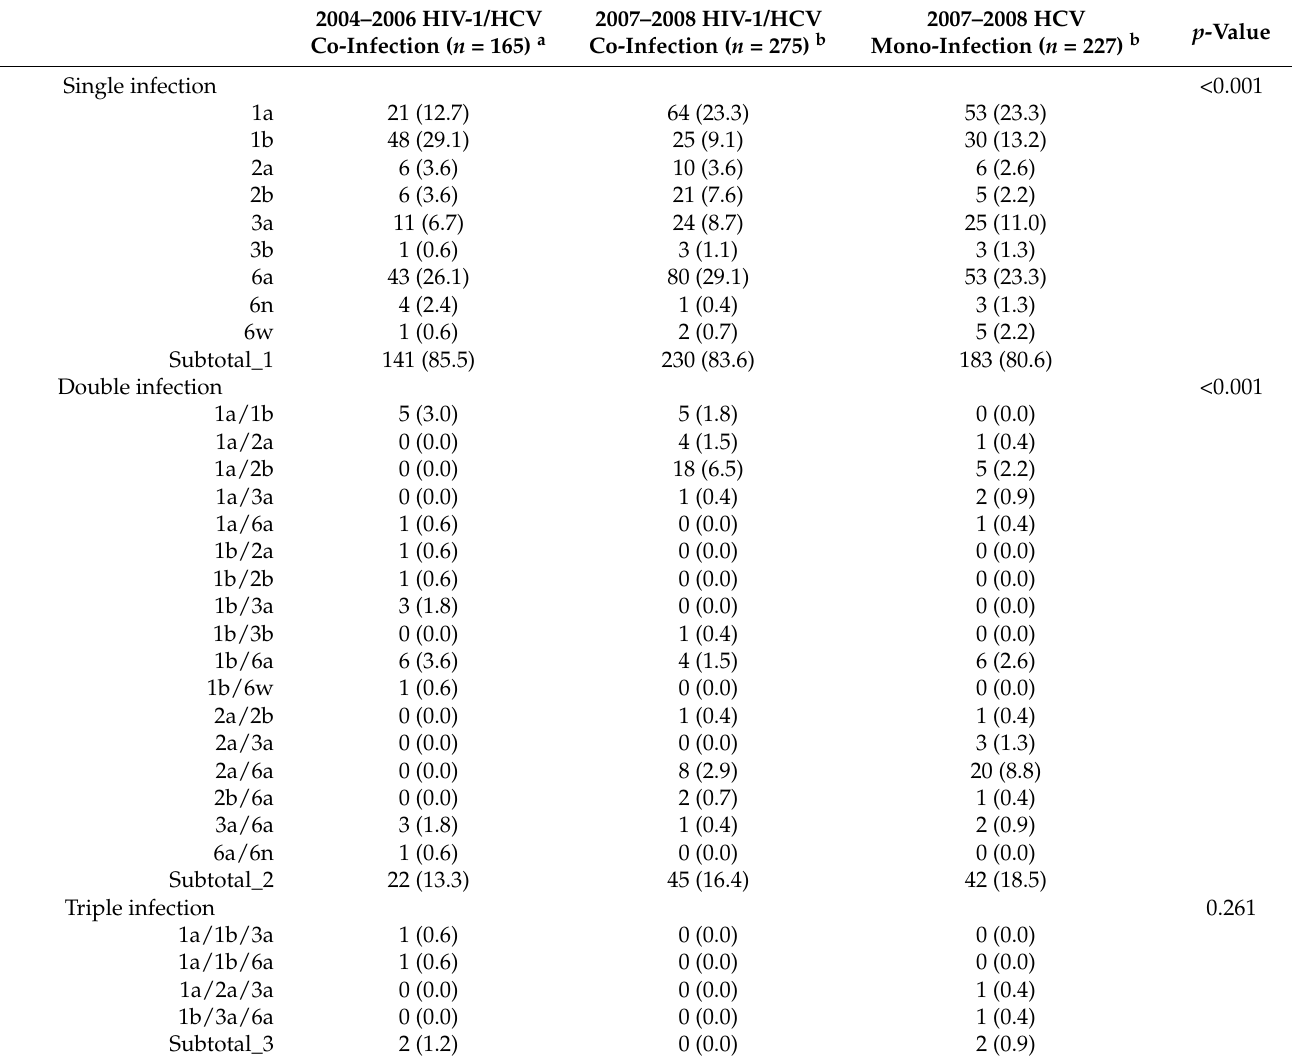
Table A1. Distribution of HCV genotypes/subtypes in the different groups among Taiwanese PWID. 2004–2006 HIV-1/HCV 2007–2008 Co-Infection ( n = 165) a